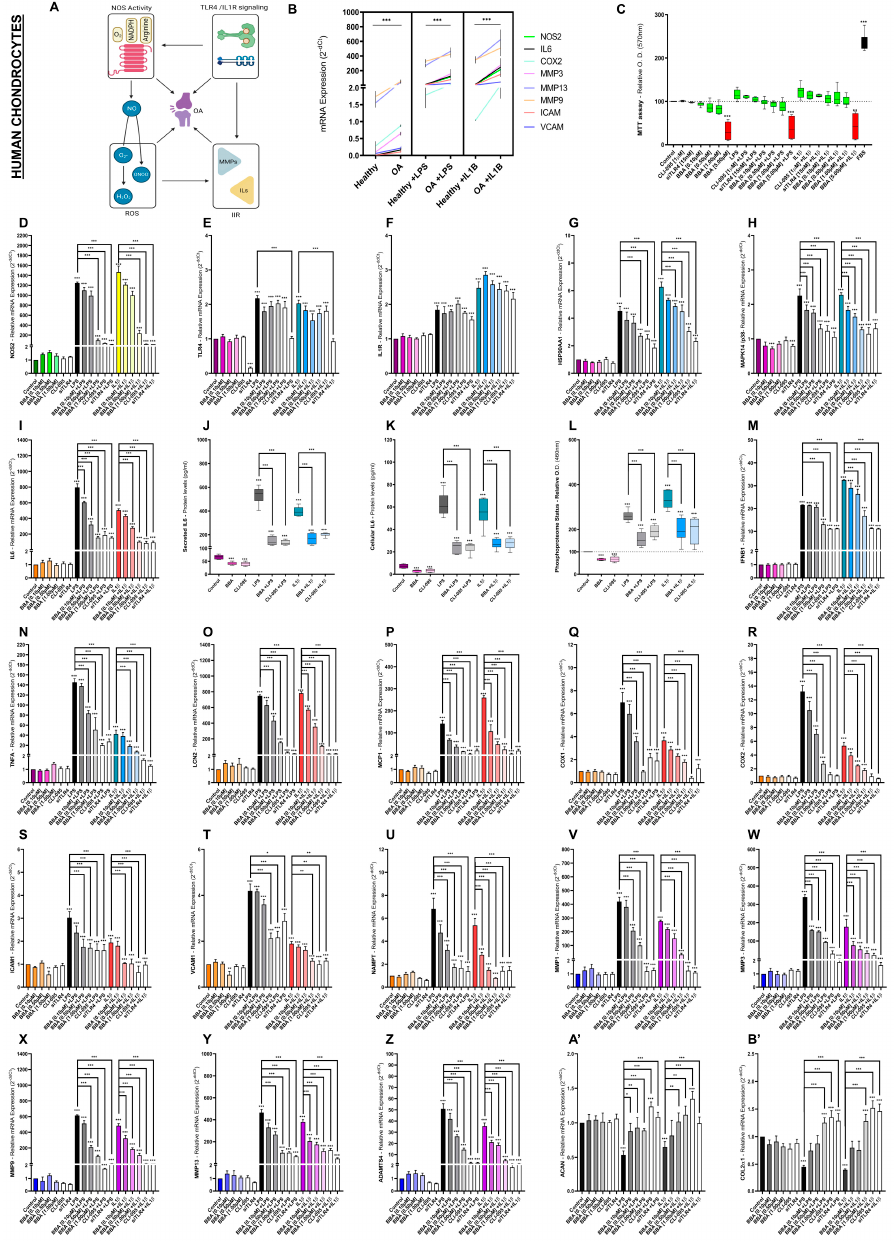
Figure 3. BBA effects on TLR4/IL1R-mediated innate immune response in primary human OA and healthy chondrocytes: ( A ) diagram of the interconnection between Osteoarthritis (OA) and TLR4/IL1R signaling, NOS activity, Reactive Oxygen Species (ROS) as well as Innate Immune Re- sponses (IIR); ( B–B’ ) primary human healthy ( B ) or OA ( B – B’ ) chondrocytes (hOC) were treated with BBA (0.10–5 µM), CLI-095 (1 µM), or siTLR4 (15 nM) for 24 h and cotreated with LPS (100 ng/mL) or IL1 β (0.1 ng/mL) for another 48 h. Independent biological replicas ( n = 6) were normalized (control), expressed as the mean ± SEM and represented by the statistical significance NEJM system as *** ( p -value < 0.001), ** ( p -value < 0.002), * ( p -value < 0.033); ( C ) MTT cell viability assay in hOC chon- drocytes displaying cell inviable doses (red), cell-viable doses (green) and FBS as a positive control; ( B , D – I , M – B’ ) RT-qPCR gene expression (mRNA) of NOS2, TLR4, IL1R1, HSP90AA1, MAPK14/p38, LCN2, COX1, COX2, ICAM1, VCAM1, MCP1, NAMPT, MMP-1, -3, -9, -13, ADAMTS4, and/or ACAN and COL2 α 1 in primary human healthy or OA chondrocytes; ( J – K ) ELISA of secreted ( J ) or cellular ( K ) IL6 protein (pg/mL) in primary hOC; ( L ) Green malachite assay (Relative O.D. 460 nm) of phosphoproteome status in primary